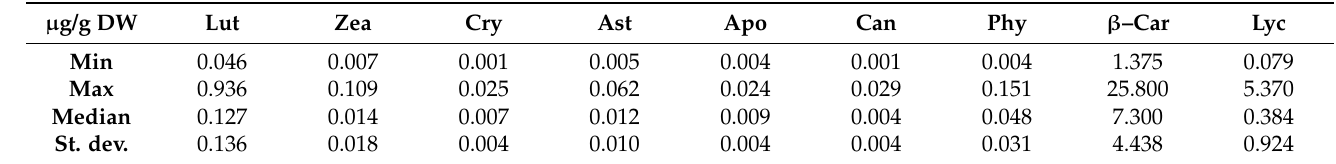
Figure 2. The amounts and standard errors of carotenoids in analyzed seeds of apple cultivars grown in Norway. Table 4. Statistical parameters for carotenoids 1 . Table 4. Statistical parameters for carotenoids